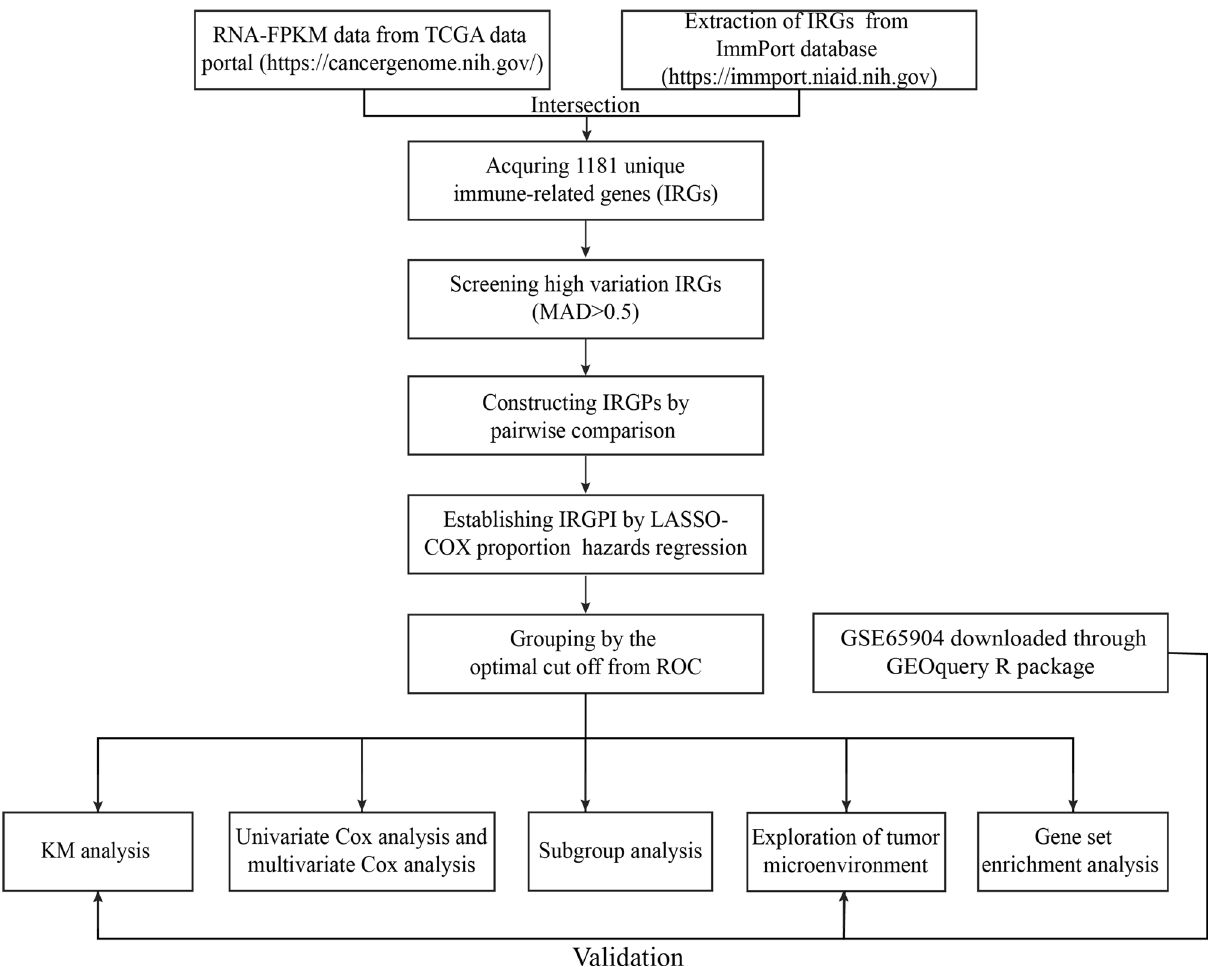
Figure 1. The flowchart of IRGPI establishment and